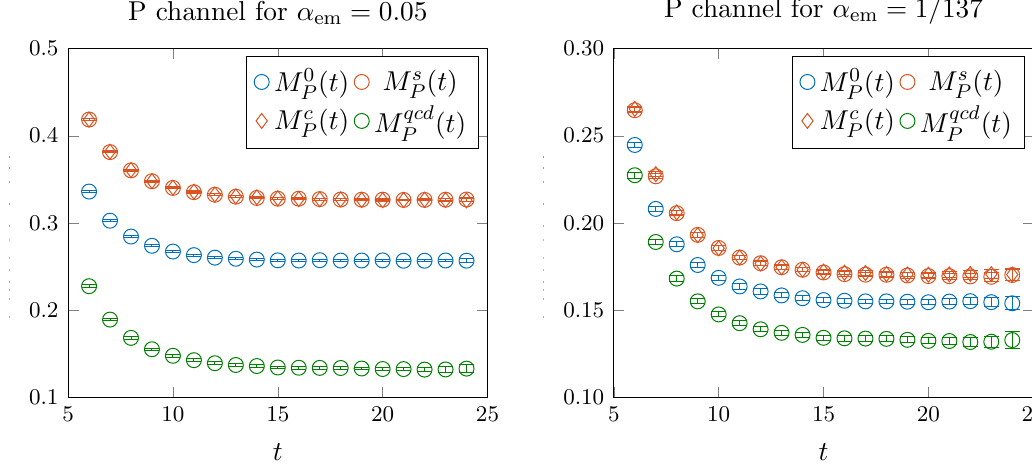
( t ). The orange points correspond to P ( t ), or the Coulomb, M c ( t ), operators. P P ( t ). The quality of the P